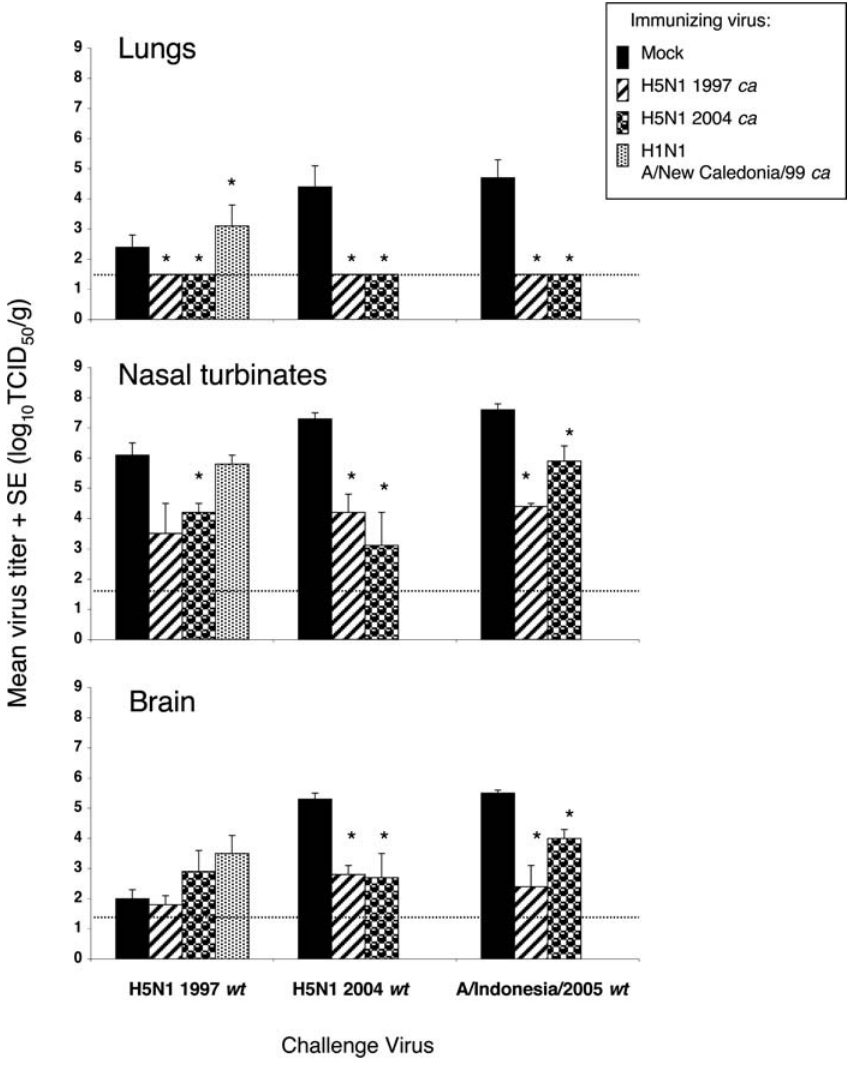
Figure 5. Efficacy in Ferrets of Two Doses of H5N1 ca Viruses against Challenge with Homologous and Heterologous H5N1 wt Viruses Ferrets were immunized with two doses of 10 7 TCID 50 of H5N1 1997 ca or H5N1 2004 ca viruses 1 mo apart and challenged 1 mo later with 10 7 TCID 50 of either H5N1 1997 wt, H5N1 2004 wt, or A/Indonesia/05/2005 (H5N1) wt . In order to determine the contribution of the internal protein genes of the AA ca virus to protection, an additional group of ferrets was immunized with H1N1 A/New Caledonia/99 ca and challenged with H5N1 1997 wt . These ferrets were not challenged with H5N1 2004 wt or A/Indonesia/05/2005 (H5N1) wt . Lungs, nasal turbinates, and brains were harvested 3 d after challenge and were homogenized and titered on MDCK cells. Three ferrets per group were evaluated. The lower limit of detection is indicated by the dashed line. * p , 0.05 compared to mock-immunized ferrets. DOI: